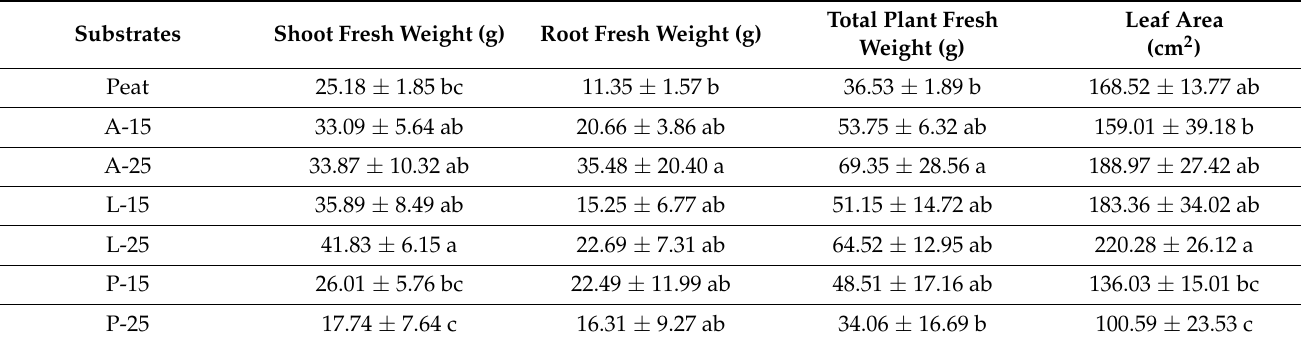
Table 8. Morphological parameters of strawberry cv. ‘Honeoye’ cultivated in different substrates (mean ± SD). Substrates